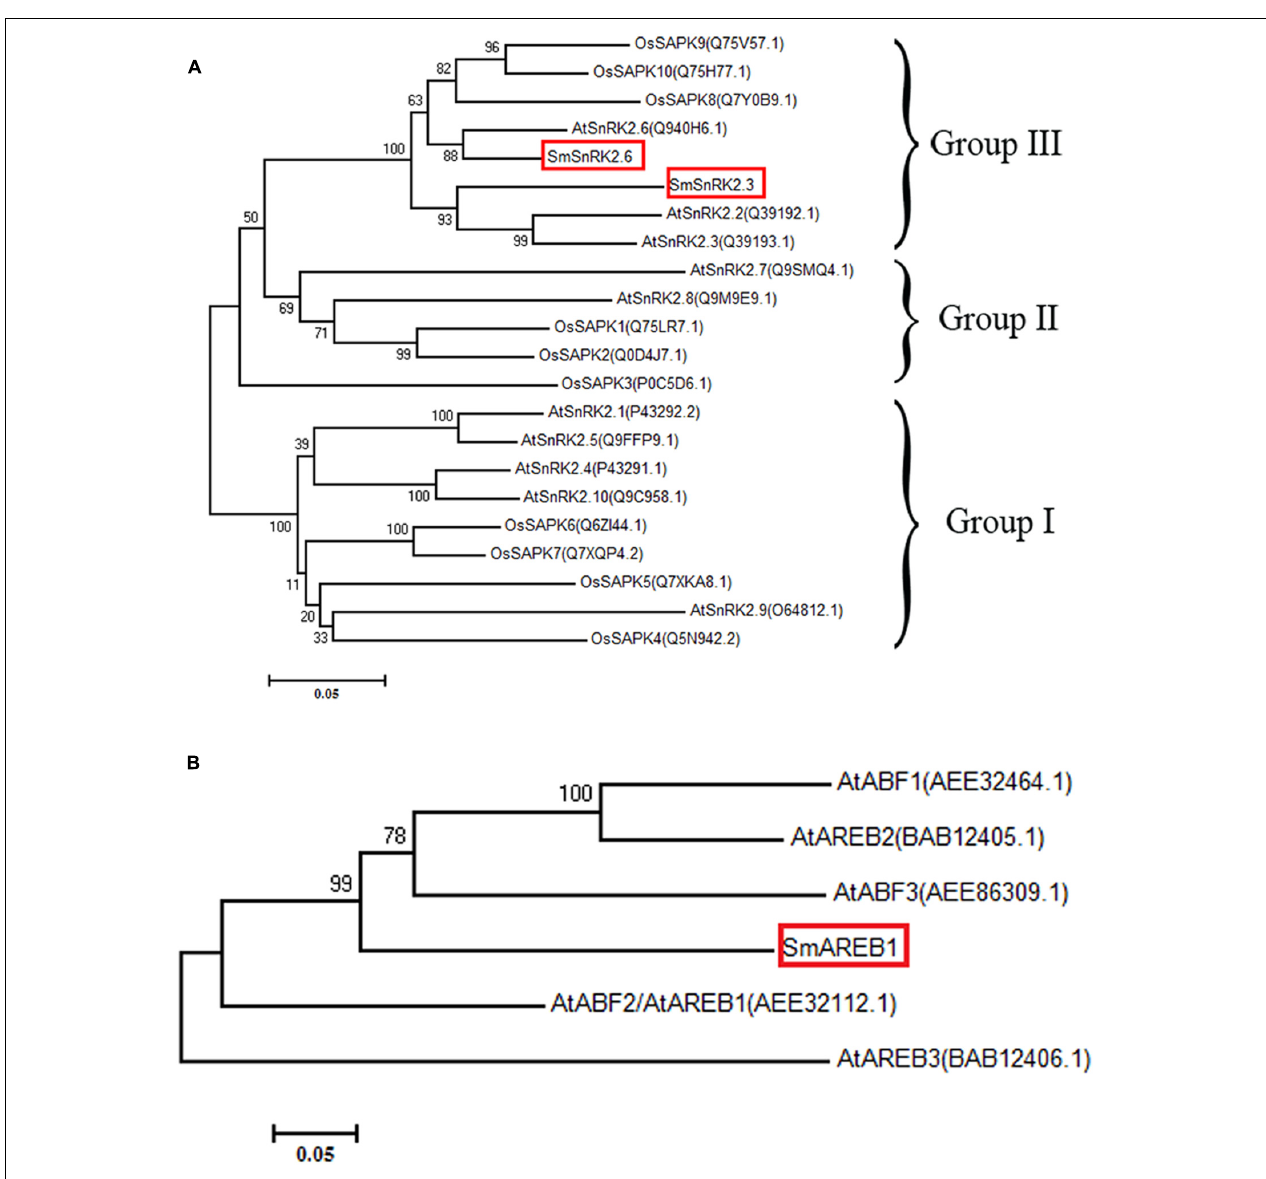
FIGURE 2 | Phylogenetic analysis of SmSnRK2.3 , SmSnRK2.6 , and SmAREB1. (A) A phylogenetic tree constructed based on the amino acid sequences of SmSnRK2.3/2.6 (boxed in red) and SnRK2 family proteins from A. thaliana (At) and O. Sativa (Os). (B) Phylogenetic tree, constructed based on the amino acid sequences of SmAREB1 (boxed in red) and its orthologs in A. thaliana (At). These phylogenetic trees were constructed via MEGA7.0, using the neighbor-joining method with 1,000 bootstrap